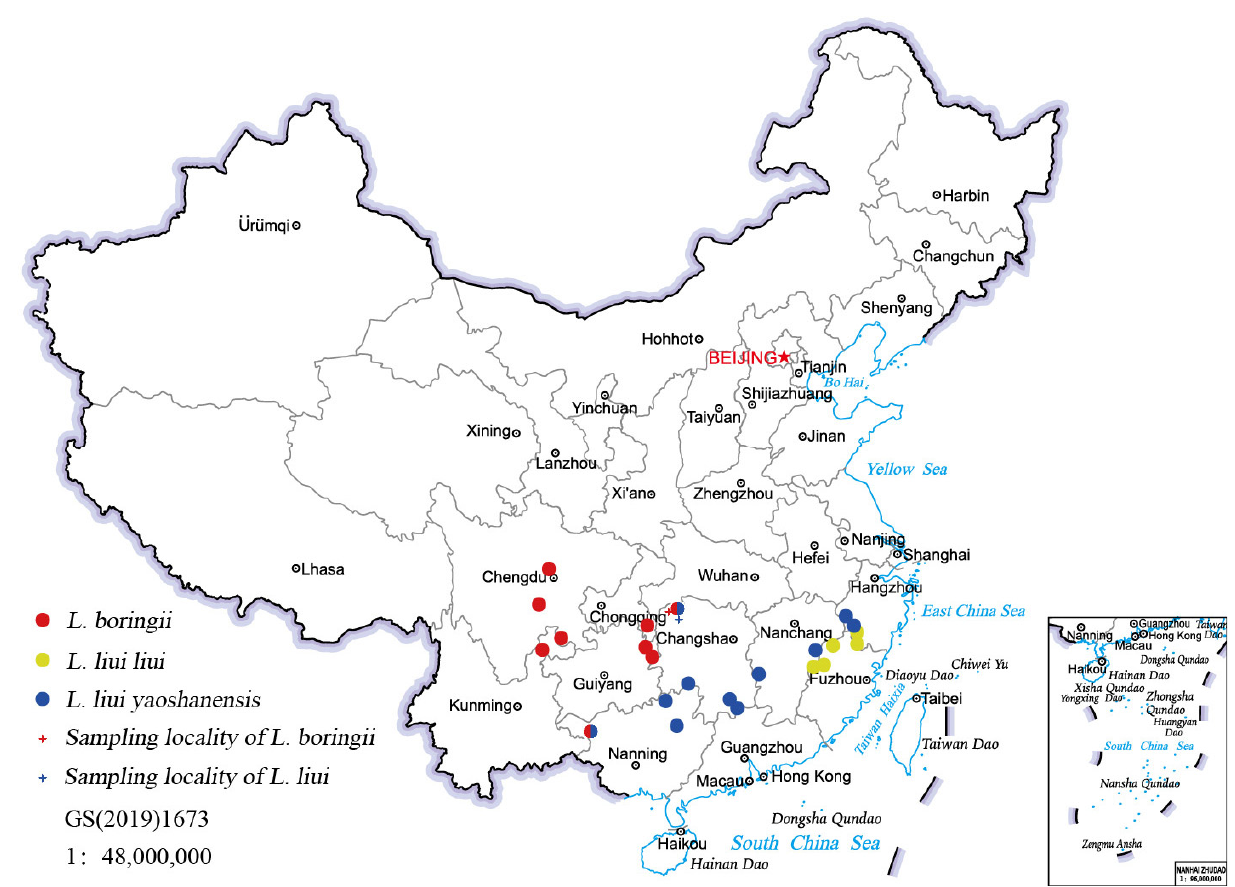
Figure 1. The recorded distribution sites of L. boringii and L. liui (data from [7]).